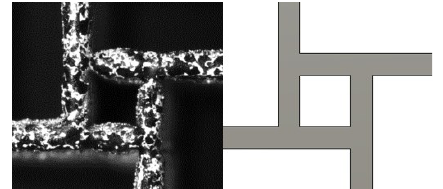
Fig. 1. Difference between a SLM printed antitetrachiral unit cell out of Scalmalloy® and its CAD equivalent. Printed geometry shows change in thickness and geometrical proportions in comparison to its CAD equivalent.